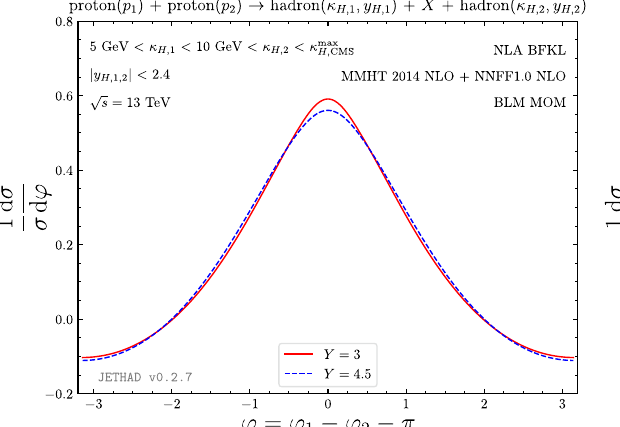
Fig. 17 NLA BFKL (left) and high-energy DGLAP (right) predic- tions for the azimuthal distribution of the inclusive hadron-jet produc- tion (central panel of Fig. 2), for two distinct values of the final-state